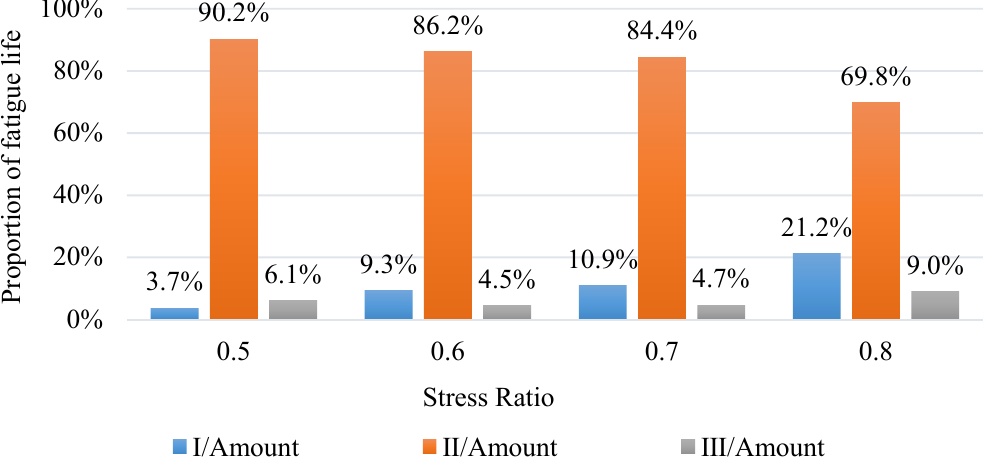
Figure 8. Percentages of fatigue cycles in stages to the total fatigue life under different stress ratios.